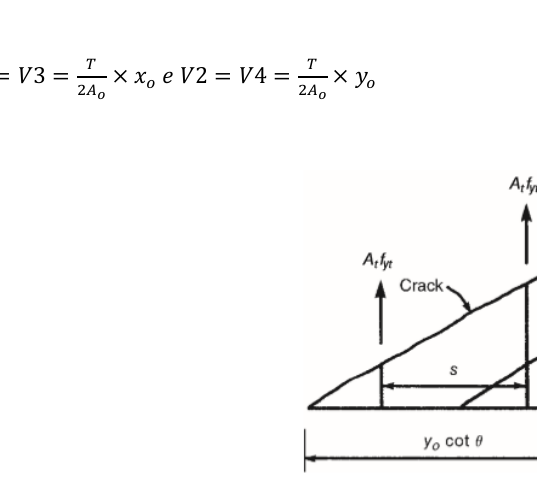
Figure 6: Section of the vertical wall detailing the stirrups force